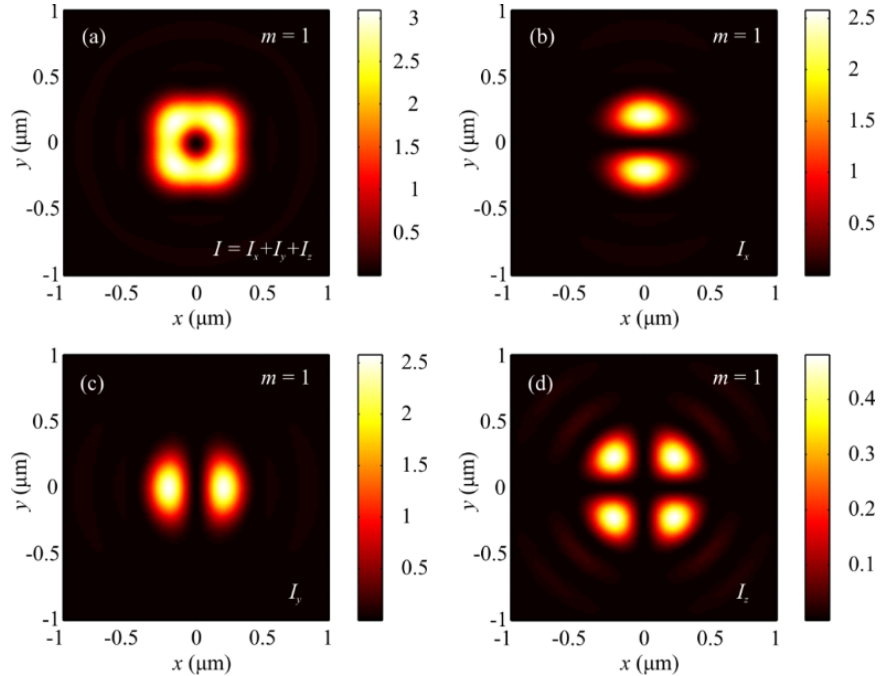
Figure 1. Patterns of ( a ) intensity and its components ( b ) Ix, ( c ) Iy, and ( d ) Iz in the focal plane when focusing a plane wave with the hybrid polarization of Equation (1) at m = 1.